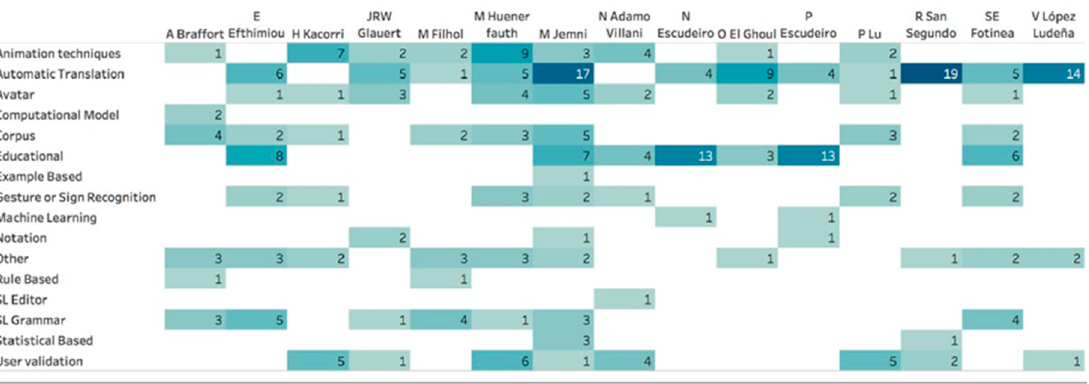
Figure 7. Classifications–Top authors heatmap.